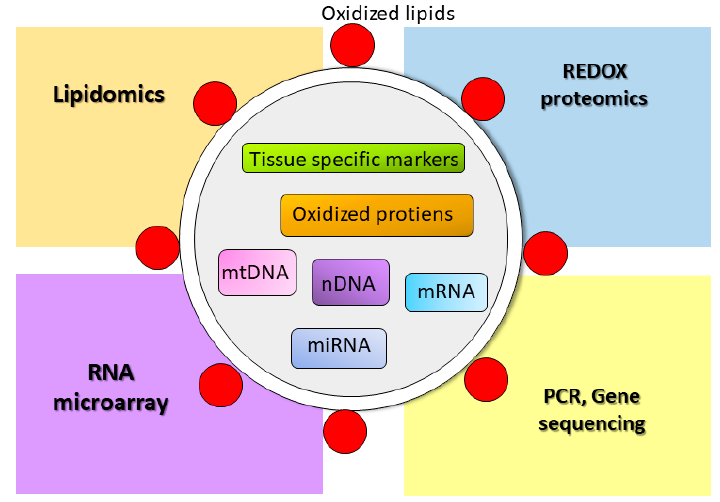
Figure 2. Candidate molecules in extracellular vesicles (EVs) for oxidative stress biomarkers.